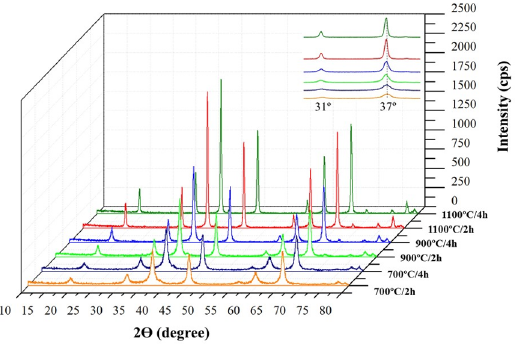
Figure 3. XRD patterns of MgAl